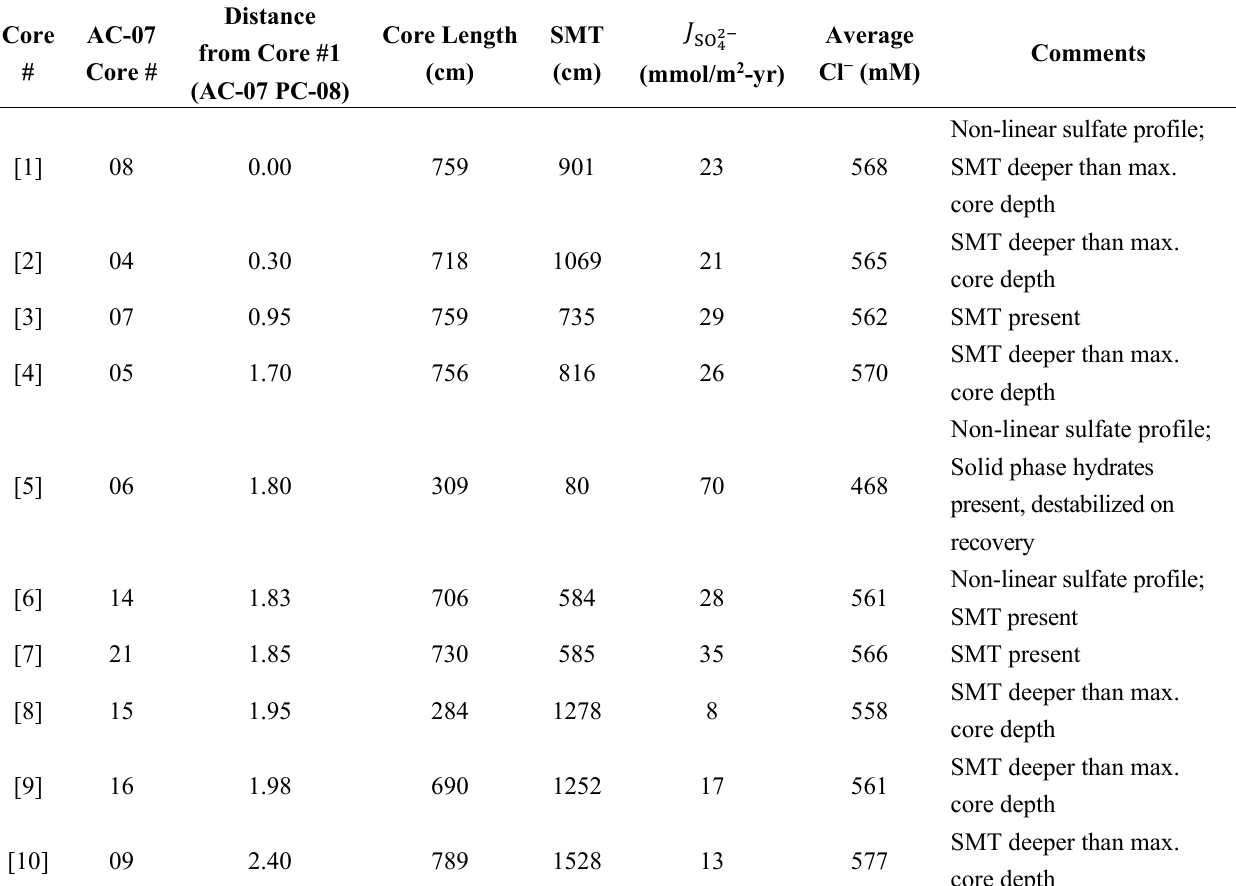
Table 1. Estimated sulfate methane transition (SMT) depths, sulfate diffusion rates ( (cid:1836) and average porewater Cl − concentrations for AC-07 piston cores (PC) referenced to AC-07 PC-08. Core PC-06 contained solid phase hydrates which destabilized during